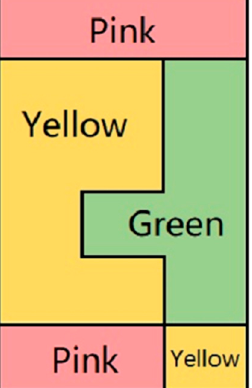
Figure 13. The priority domain distribution of the sensor locations in the east-facing room.